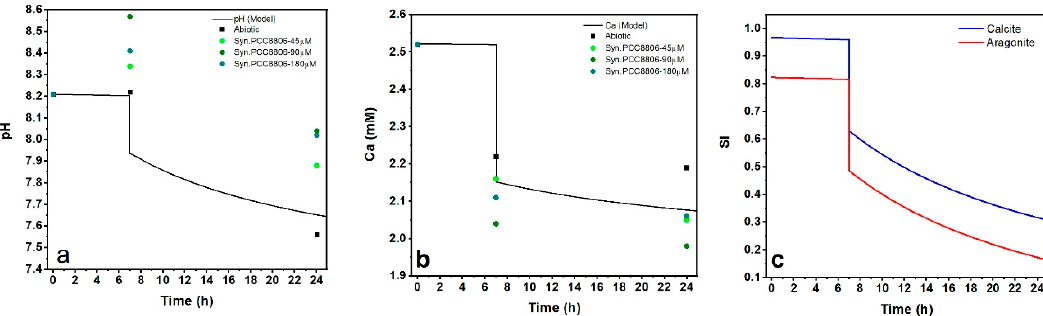
Figure 6. Dynamics of pH: ( a ) [ Ca 2+ ] and ( b , c ) saturation indices in the precipitation reactions predicted with PHREEQC Interactive. The dots represent the experimental data used in comparisons to the model output: Abiotic ( ■ ); Syn. PCC8806 biomass ( 45 μM, 90 μM, 180 μM).